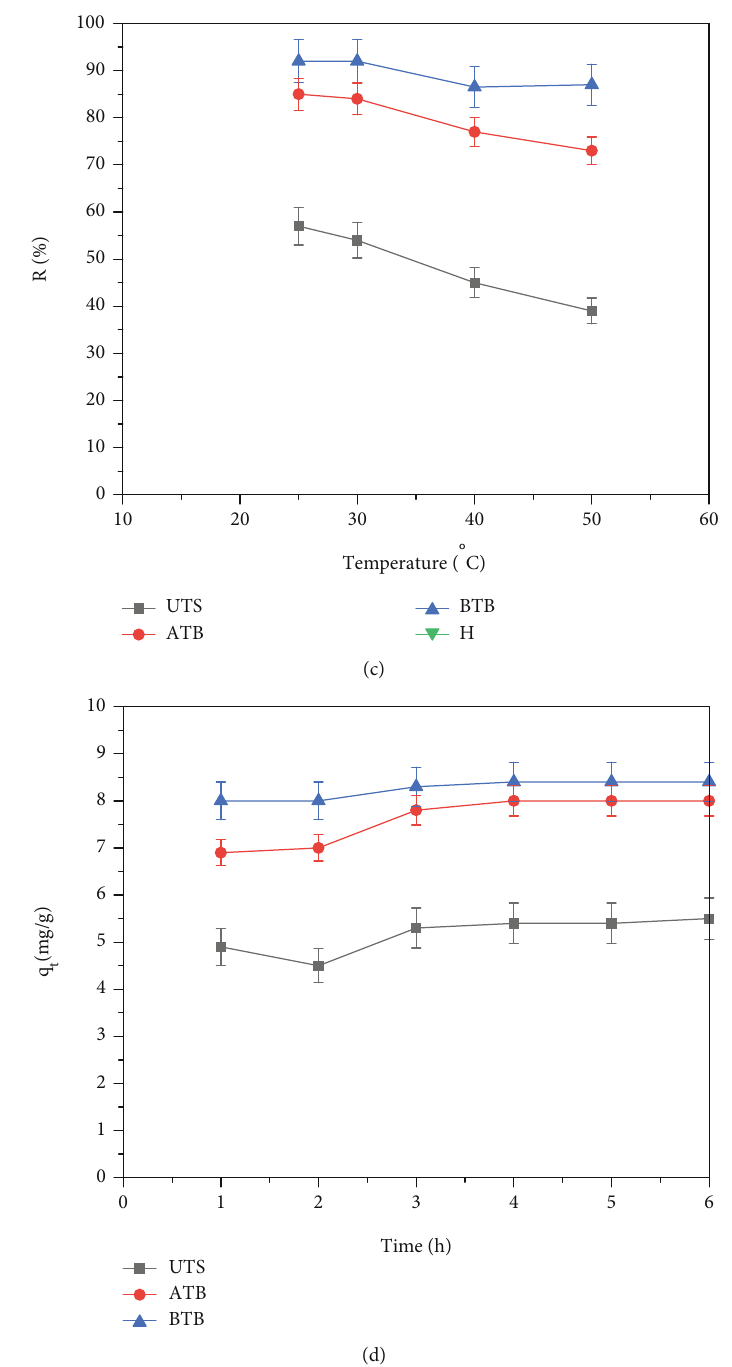
Figure 8: E ff ect of parameters on adsorption capacity of Cr (VI) metal ion: (a) biosorbent dosage, (b) initial Cr (VI) metal ion concentration, (c) temperature, and (d) contact